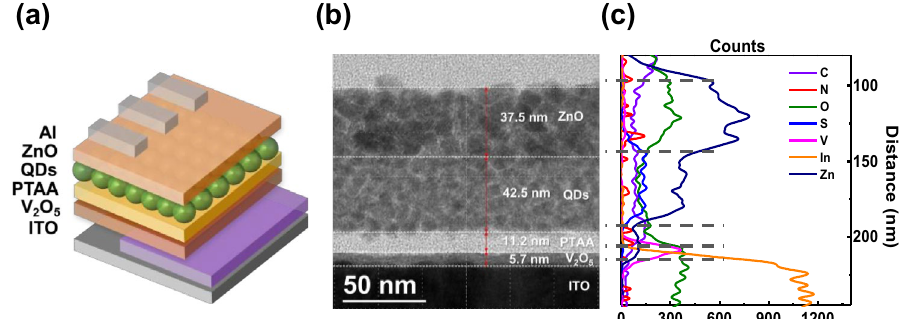
Figure 1. ( a ) Schematic structure of the QLEDs with UVO 40. ( b ) Cross-sectional HR-TEM image of the QLEDs with UVO 40. ( c ) EDS line scan of the elemental